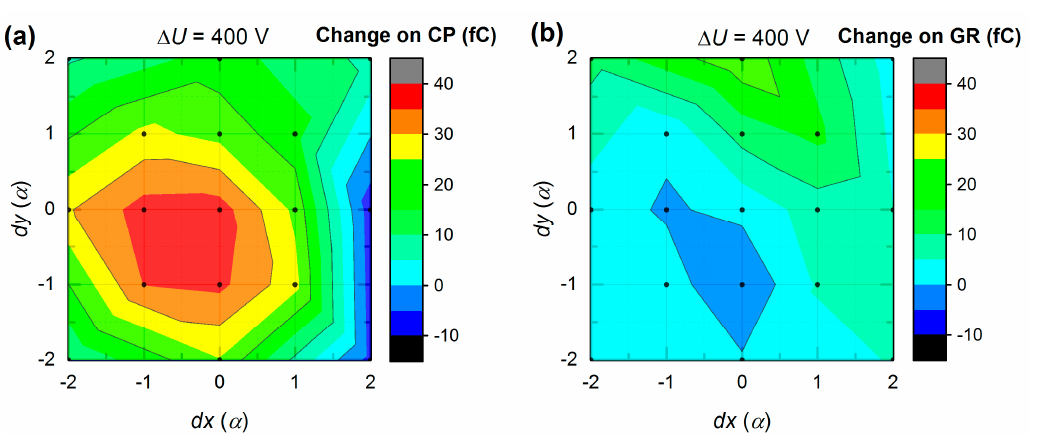
Figure 13. Maps of CC changes on ( a ) CP and ( b ) GR at Δ 400 V bias variation (from 400 V to 800 V) ( α = 0.85 mm).